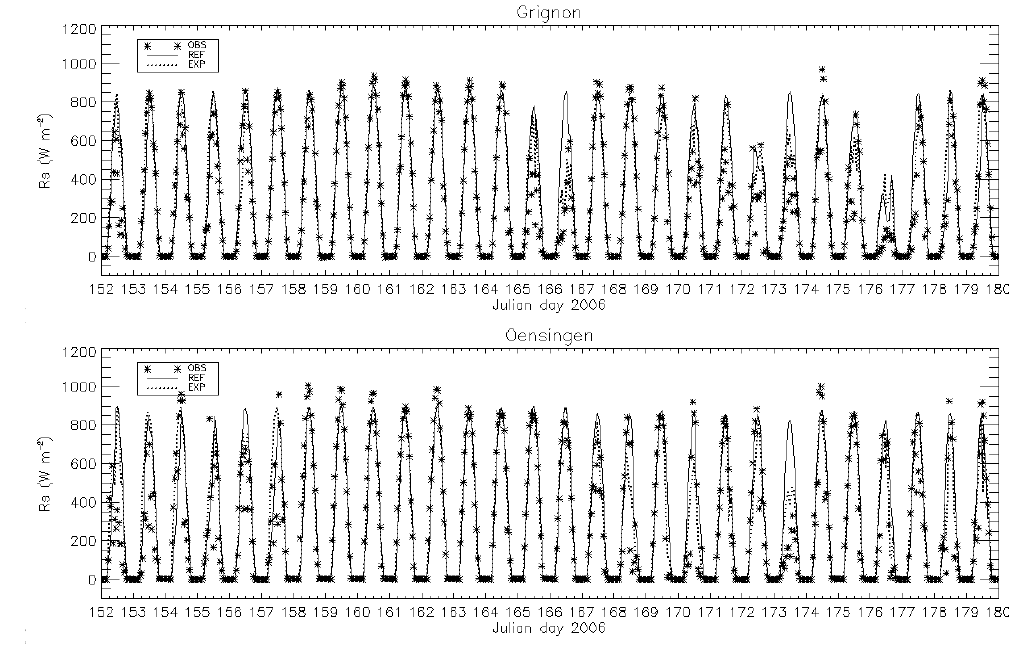
Figure 4: Incoming shortwave radiation at Grignon (upper panel) and Oensingen (lower 4 Fig. 4. Incoming shortwave radiation at Grignon (upper panel) and Oensingen (lower panel) for June 2006. panel) for June 2006. 5